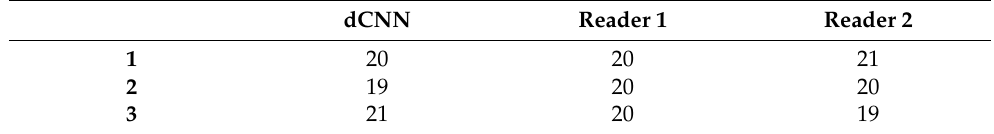
Table 2. Classification of 60 test images by the dCNN and the two readers according to the 3 classes